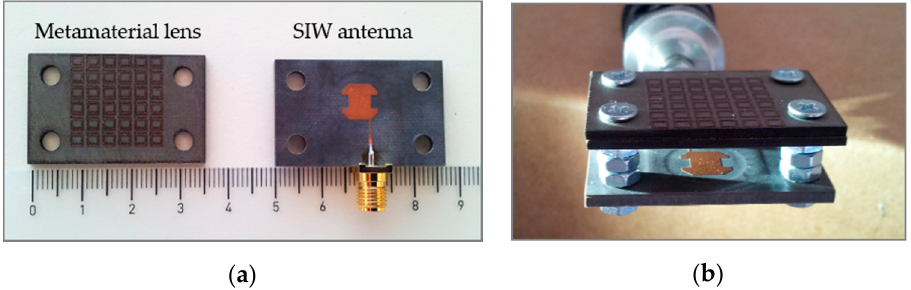
Figure 9. ( a ) The metamaterial lens (at left) and SIW cavity-backed patch antenna (at right) prototypes. ( b ) SIW antenna and metamaterial superstrate assembled and connected to the Agilent Technologies N5224A Network Analyzer.